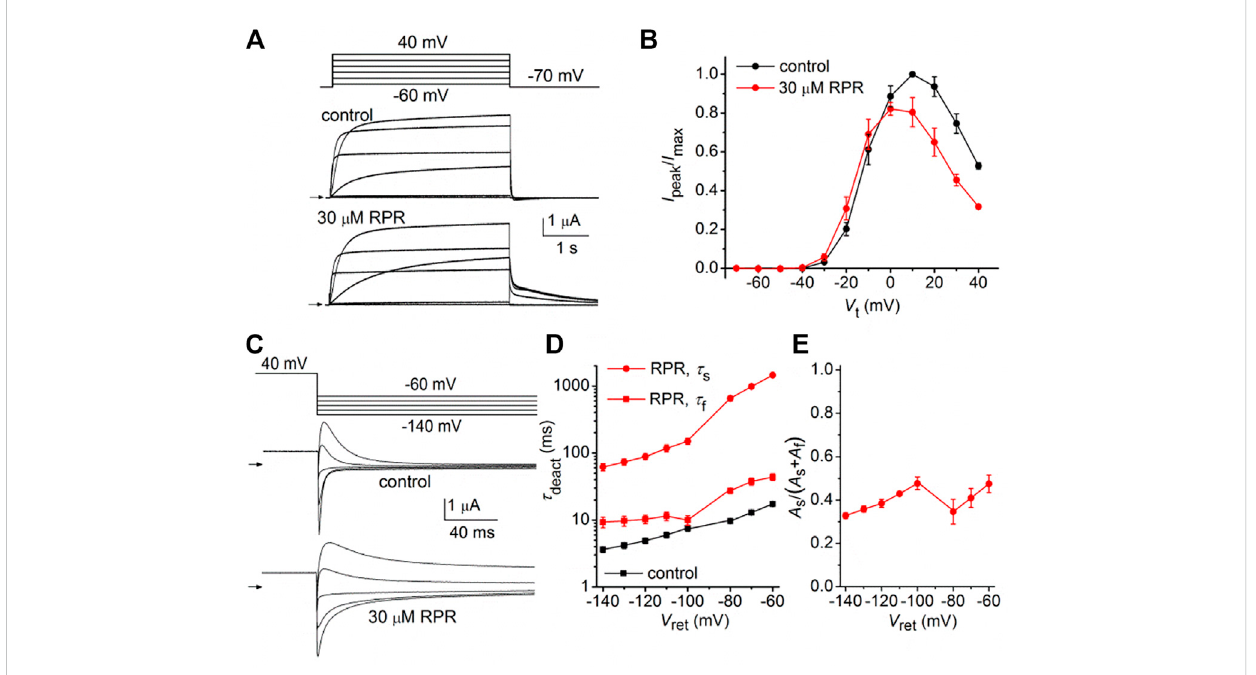
FIGURE 4 Effects of RPR on N-terminal deleted hERG1a channel currents. (A) Voltage pulse protocol and cooresponding N-del hERG1a channel currents recorded from an oocyte before (control) and after treatment with 30 µM RPR. Horizontal arrows indicate zero current level. (B) Effects of RPR on normalized I peak -V relationship. RPRdecreased I peak atpositive potentials ( n = 5; p < 0.002, 2way ANOVA). (C) Voltagepulse protocol and corresponding currentsrecordedbefore(control)andaftertreatmentwith30 µMRPR. (D) Plotof τ deact asafunctionof V ret .Time-dependenttailcurrentdecaywas monoexponentialundercontrolconditionsandbi-exponential inthepresenceof30 µMRPR( n =6).Thefastrateofdeactivation( τ f )measuredafter RPR wasslowerthan τ deact undercontrolconditions( p < 0.001,2-wayANOVA). (E) Relativeamplitudeoftheslowcomponentofdeactivatingtailcurrentinthe presence of 30 µM RPR ( n =